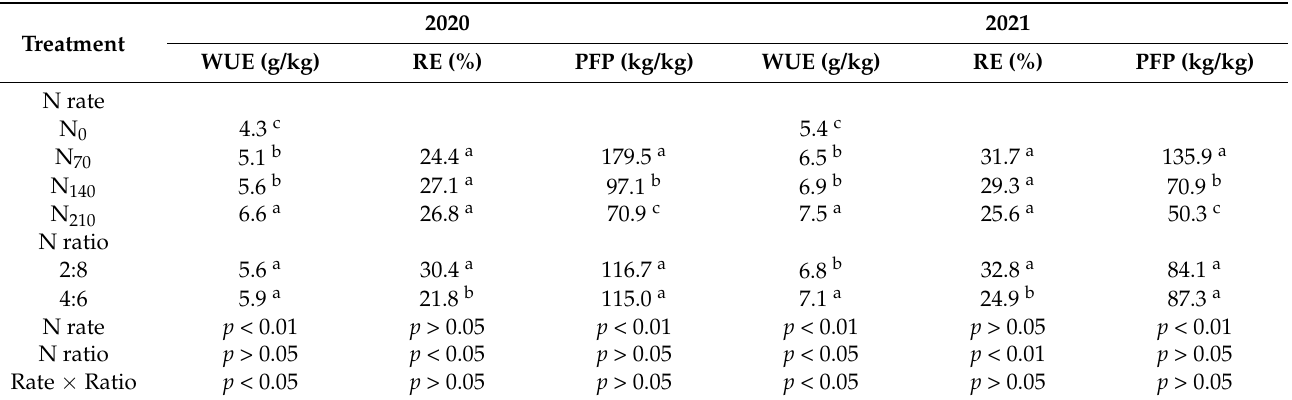
Table 7. Effects of different fertilization rates and basal topdressing ratios on WUE, RE, and PFP in 2020 and